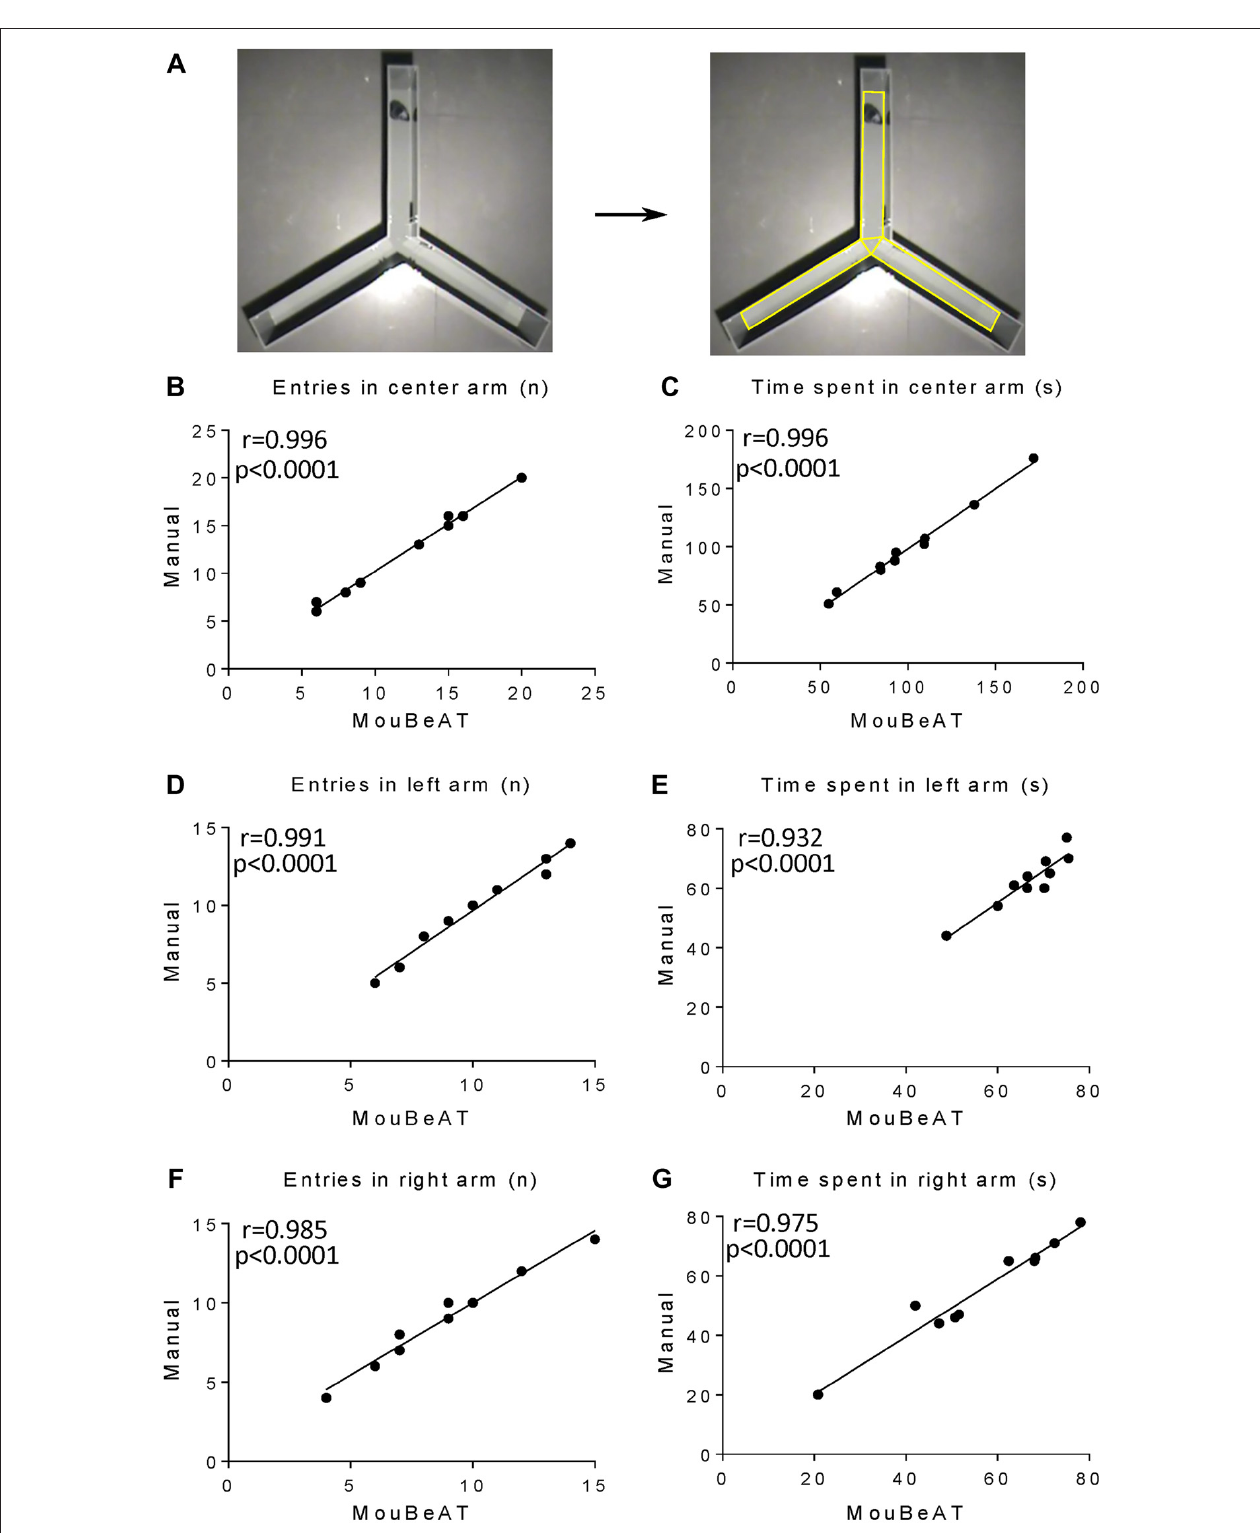
FIGURE 4 | Correlation between the results obtained with MouBeAT and those from manual assessment for the measured variables in the Y-maze (YM) test. The YM test (A) was performed using 10 C57BL/6J male mice. Yellow ROI defines the edges and central triangle of the maze. Each dot represents the number of entries into the center (B) , left (D) and right arms (F) , and the time spent in the center (C) , left (E) and right (G) arms for each mouse.